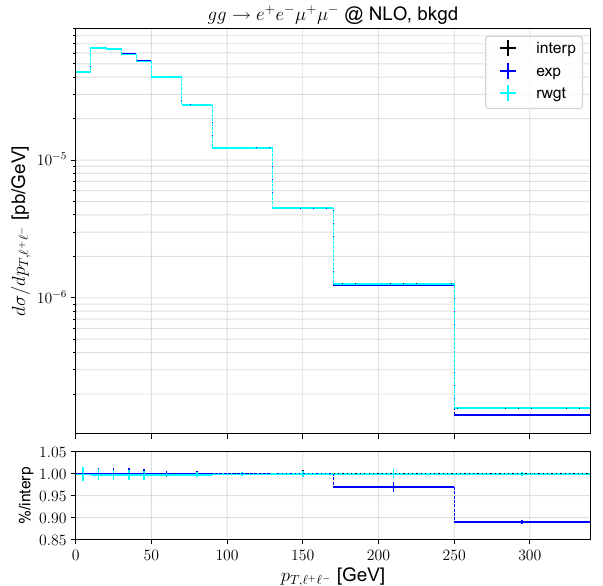
Fig. 15 Differential distribution in transverse momentum p T ,(cid:3) + (cid:3) − of the dilepton system (cid:3) + (cid:3) − = e + e − , μ + μ − in gg → e + e − μ + μ − at fixed-order NLO for the background contribution. Predictions and colour coding are as in Fig. 14